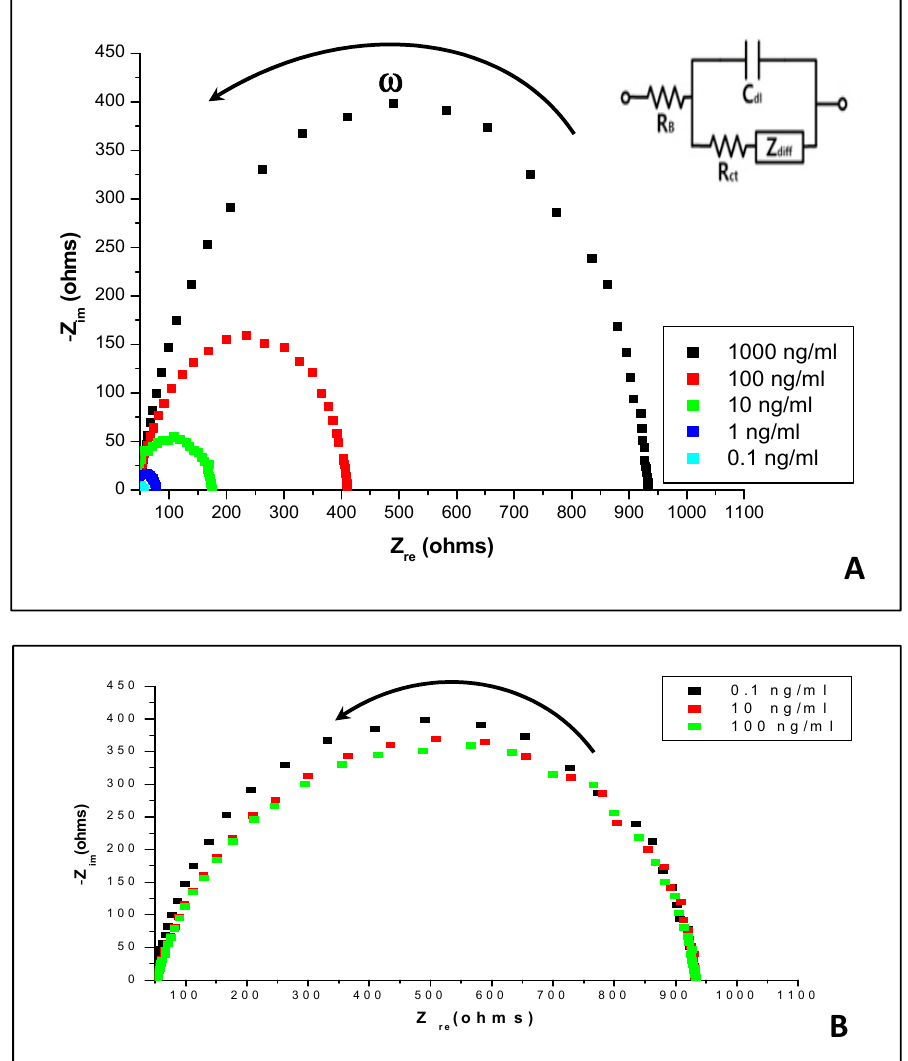
Figure 6. The Nyquist plots ( − Z im vs. Z re ) for interdigitated electrodes with immobilized anti-Hg 2+ aptamers binding Hg 2+ ions of different concentrations ( A ); the Nyquist plot for bare interdigitated electrodes in solutions with different concentrations of HgCl 2 ( B ).